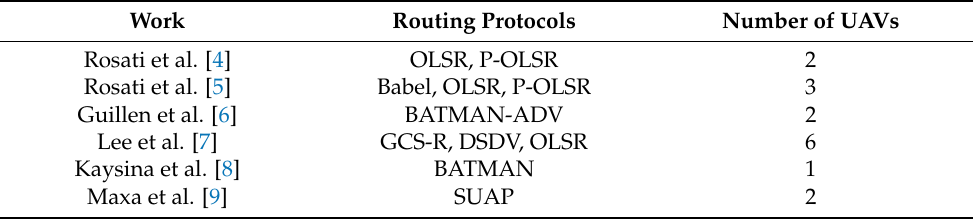
Table 1. Related works that included a real FANET deployment. Also detailed are the routing protocols employed and the number of UAVs. Work Routing Protocols Number of UAVs Rosati et al. [4] OLSR,